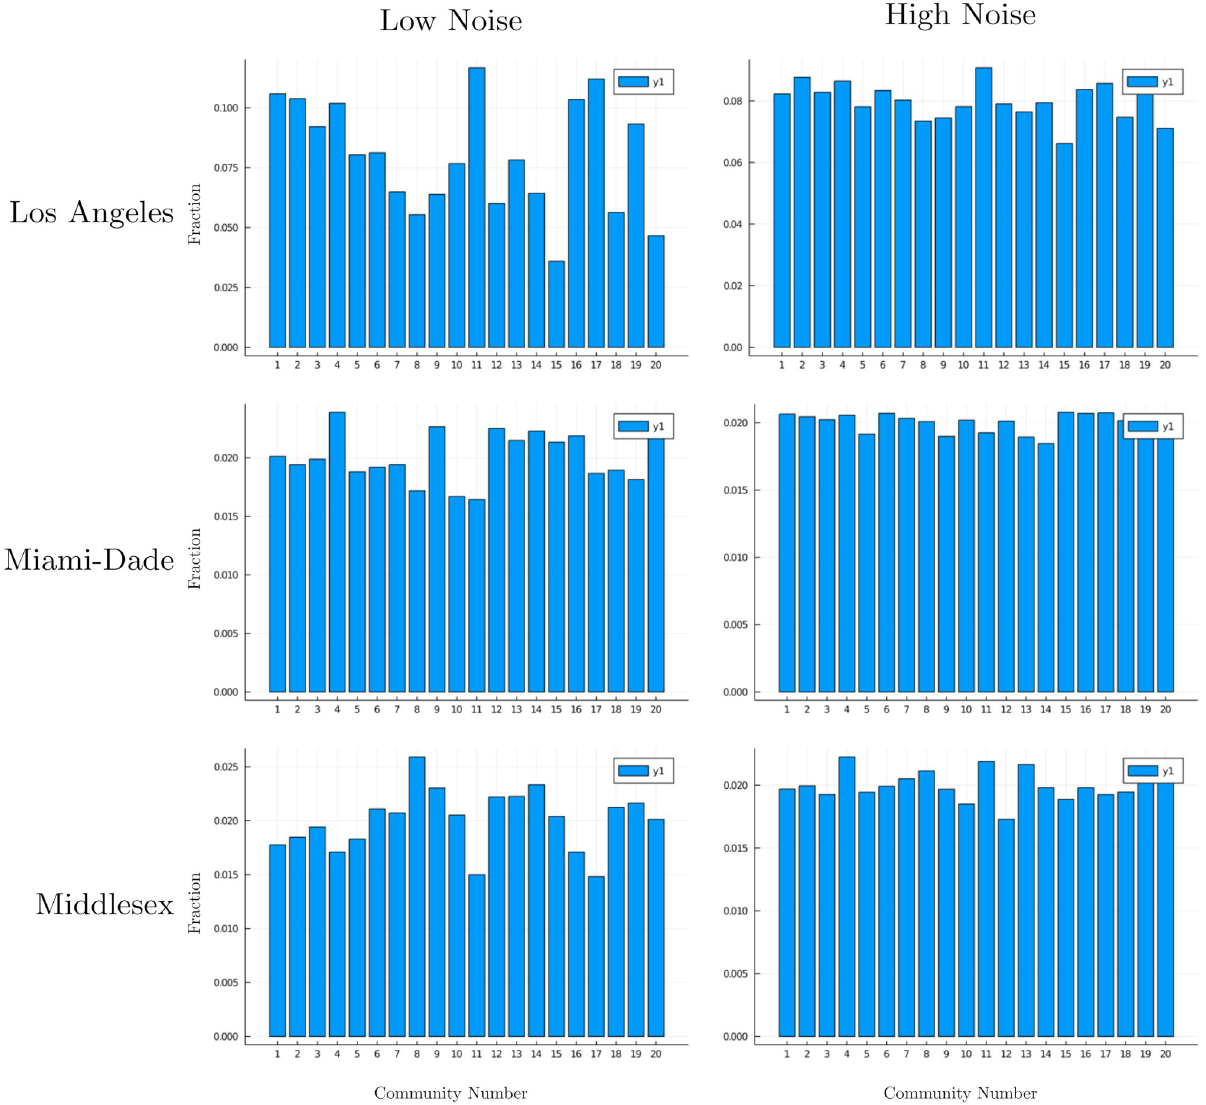
Fig 11. Varying observation noise level controls sparsity of inferred starting conditions. As noise distribution tightens, inference moves further from our uniform prior on initial community exposure rates. Low noise corresponds to ν = 0.00025, and high noise to ν = 0.0005. The network topology of each county is modeled using 20 communities which correspond to actual geographic areas. We plot m r use ν = 0.00025, a tighter observational noise than the right plots where ν =